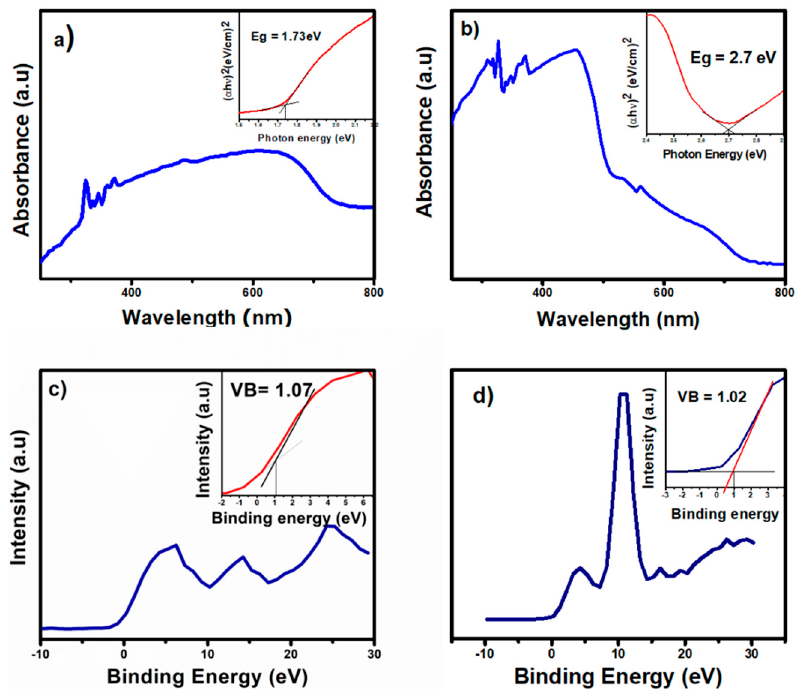
Figure 4. UV-visible DRS spectra of ( a ) MoS 2 and ( b ) ZnSe with insets showing the respective Tauc plots and band gap of MoS 2 and ZnSe. XPS spectra of ( c ) MoS 2 and ( d ) ZnSe with their respective insets showing valence band positions.